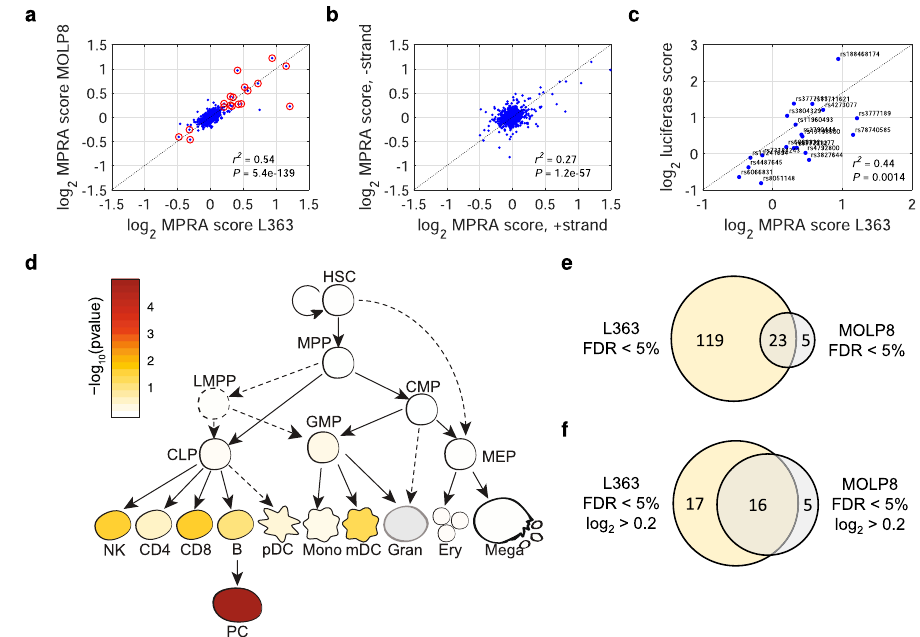
Fig. 2 Overarching analysis of screening data. We performed MPRA in the MM plasma cell lines L363 and MOLP8. a Variant log 2 scores for the L363 and MOLP8 screens. For each variant, log 2 re fl ects the transcriptional activity of the alternative relative to the reference allele. Scores were calculated based on barcode activity estimates in all six genomic contexts (i.e., across both strands and all three sliding windows) and three replicates per cell line. Variants with strong effects (absolute log 2 score >0.2) in either screen are indicated in red. Pearson r and two-sided P values are shown. b Calculating log 2 scores using either positive-strand ( x -axis) or negative-strand constructs ( y -axis) for the same variant, we did not observe strand bias. c As an additional assay validation step, we carried out luciferase experiments for 20 variants, showing a signi fi cant positive correlation between the MPRA effect ( x -axis) and the luciferase effect ( y -axis). d g-chromVAR analysis of screened variants, weighted by their L363 log 2 scores showed enrichment of variants with strong MPRA scores in genomic regions with accessible chromatin in plasma cells, consistent with our assay selecting variants with endogenous regulatory activity. e Numbers of signi fi cant variants with FDR <5% in the two cell lines. f Numbers of variants showing both FDR <5% and strong effects (absolute log 2 score